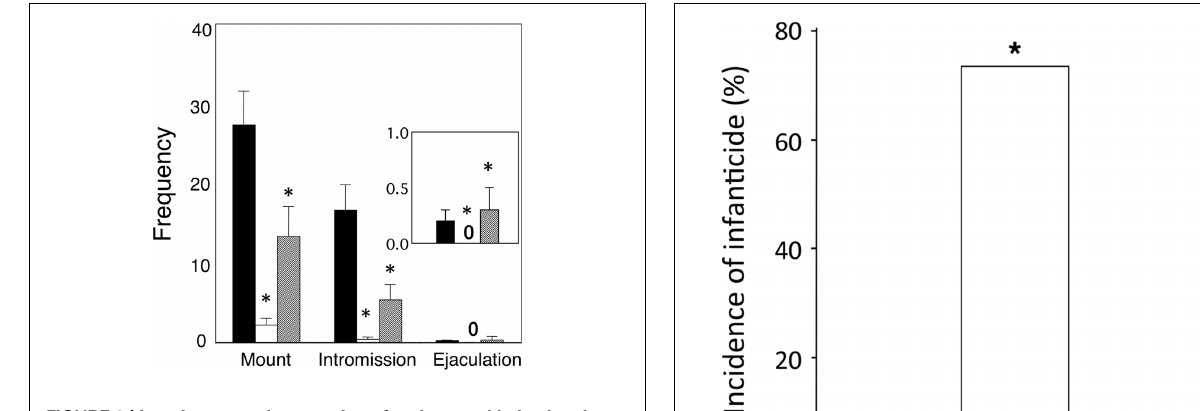
FIGURE 2 | Impairment and restoration of male sexual behaviors in ArKO andArKO/bsArTG mice, respectively. The behavioral tests were performed using wild-type ( n = 9), ArKO ( n = 11), and ArKO/bsArTG ( n = 9) male mice aged 11–13weeks.The frequency of mount, intromission, and ejaculation during a 30-min test was examined in the wild-type (solid bars), ArKO (open bars), and ArKO/bsArTG (hatched bars) mice. An insert is a enlarged graph of the ejaculation frequency.The frequency of each behavior is indicated by the mean ± SEM. Significant differences of wild-type vs. ArKO (impairments) and ArKO vs. ArKO/bsArTG (restorations) are shown (* p < 0.01).